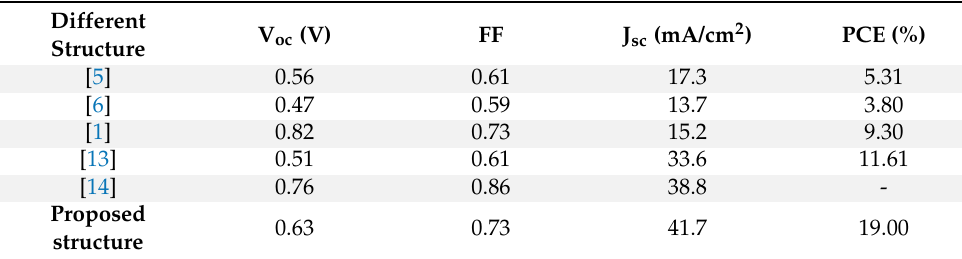
Table 8. Comparison between other solar cells and the proposed